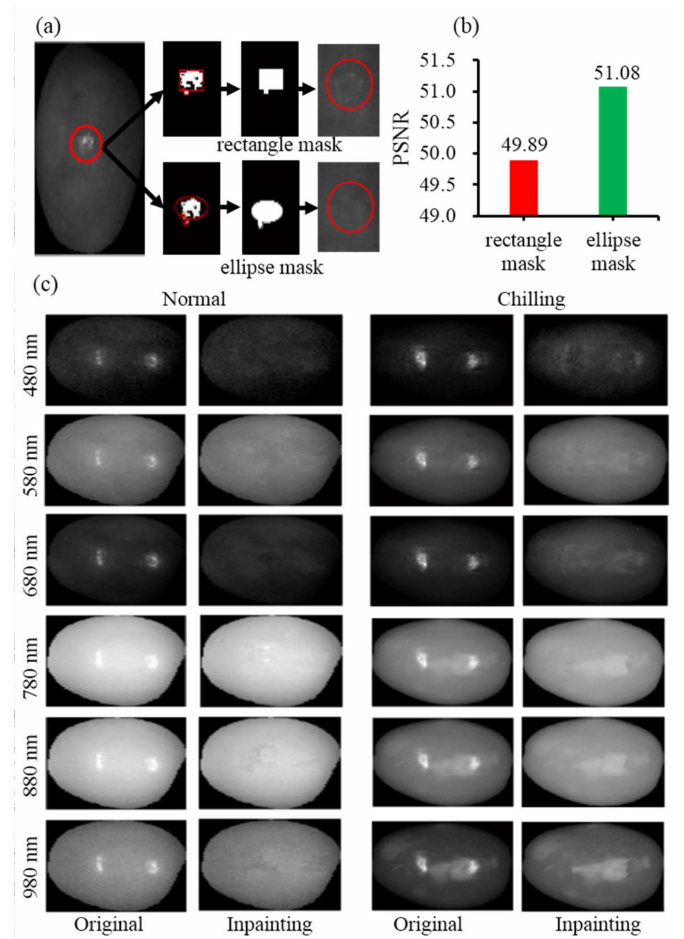
Figure 2. Effect of different shapes of specular reflection region mask on inpainting performance ( a ), peak signal-to-noise ratio of different shapes of mask ( b ) and spectral images at some representative wavelengths of normal and chilled samples before and after inpainting ( c ) using 2 × 2 binning operation (spectral resolution of 1.25